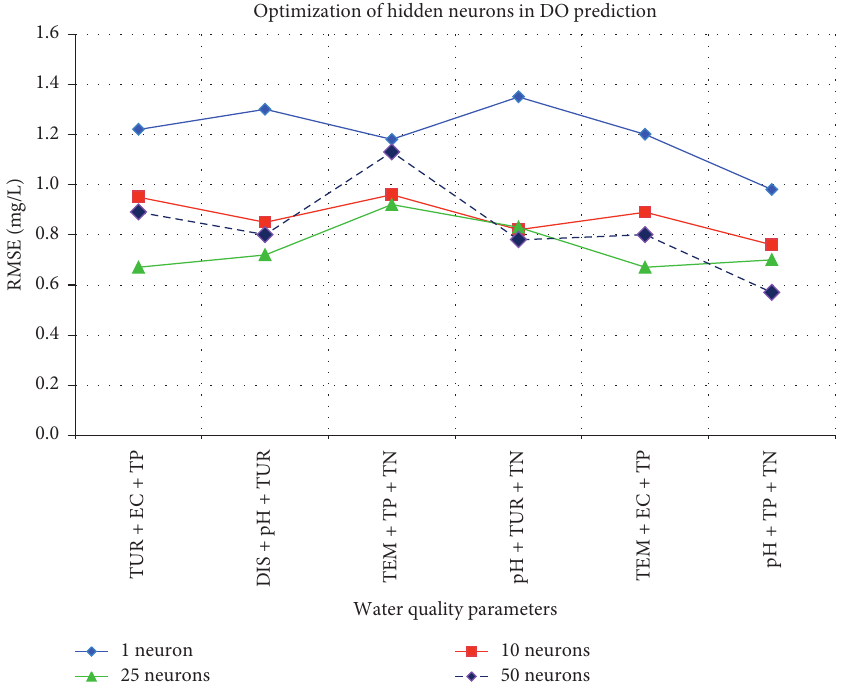
Figure 8: Performance evaluation for the selection of hidden layer for DO prediction using FNN.